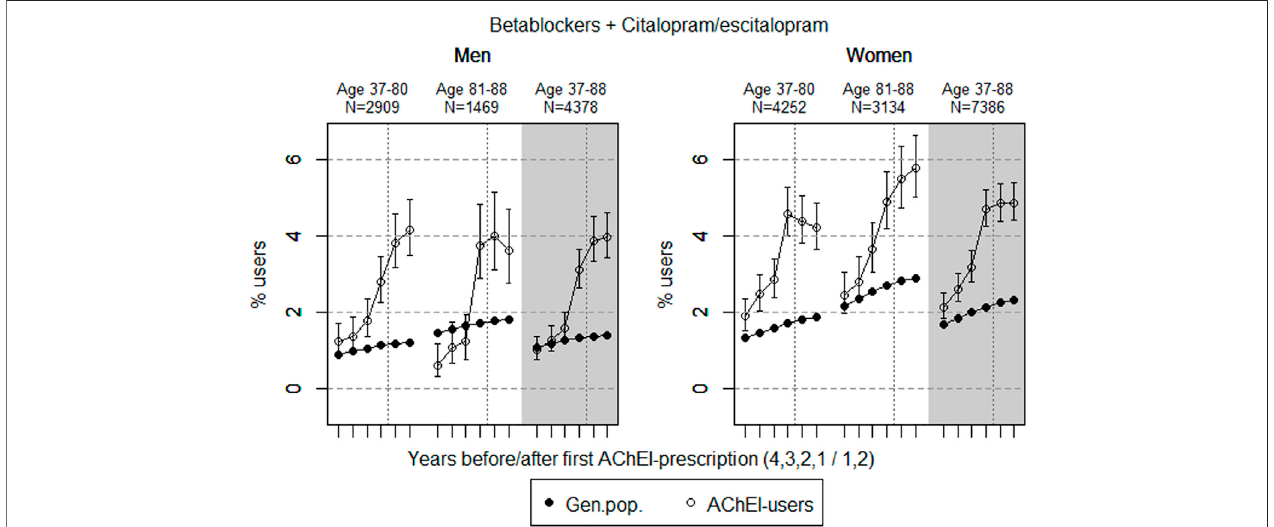
FIGURE 7 | Bullets: Proportion of men and women, respectively, of the study population who used combinations of betablockers and citalopram/escitalopram in the 4 years before AChEI initiation and the 2 years after with 95% con fi dence intervals. Circles: The corresponding age adjusted proportion in the general population. Dashed vertical lines indicate AChEI initiation. The size of each age group in the study population is given on